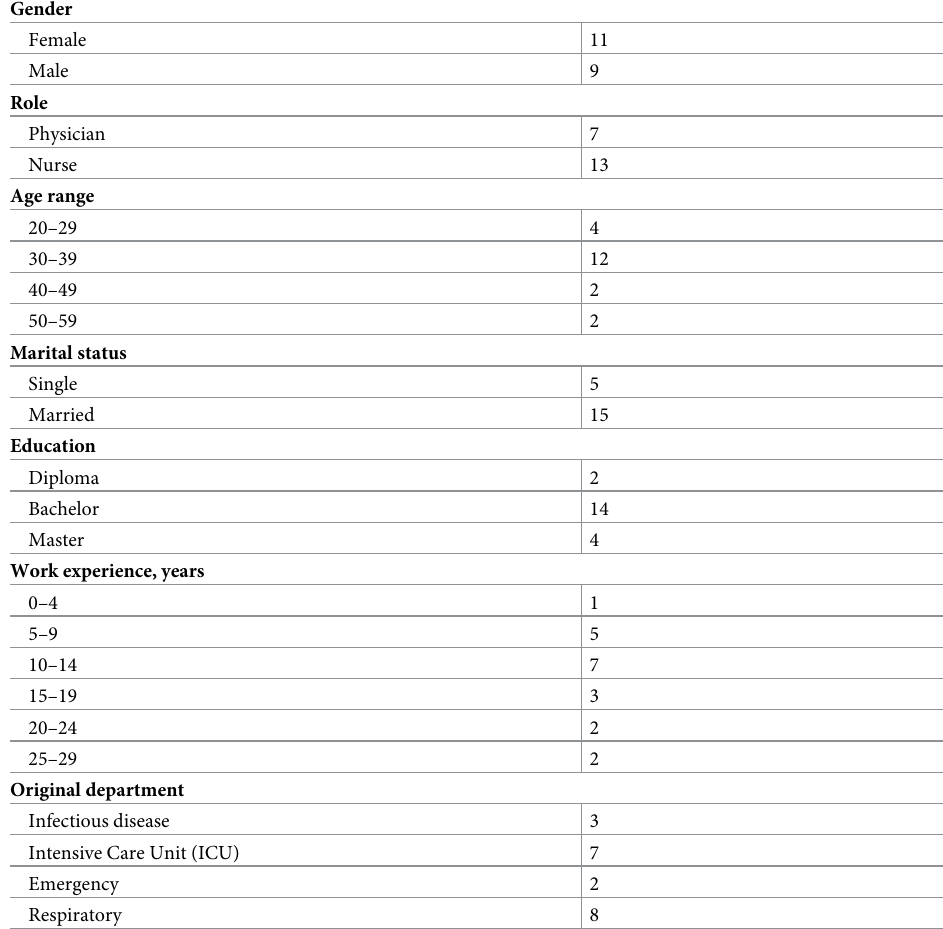
Table 1. Characteristics of healthcare workers redeployed to Wuhan (n =